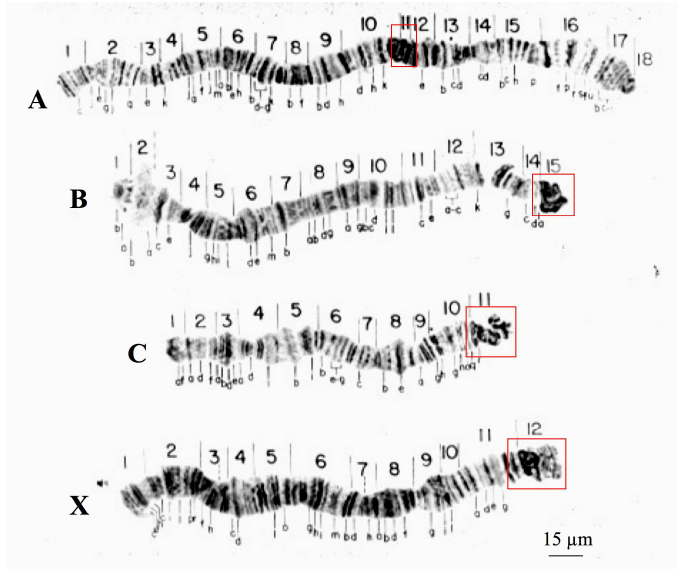
Figure 1. Polytene chromosomes of R. americana modified from [16]. Boxes (red) are signaling chromosome sections comprising centromeric and pericentric regions. Chromosome nomenclature ( A – D ) as well as section numbering was described previously